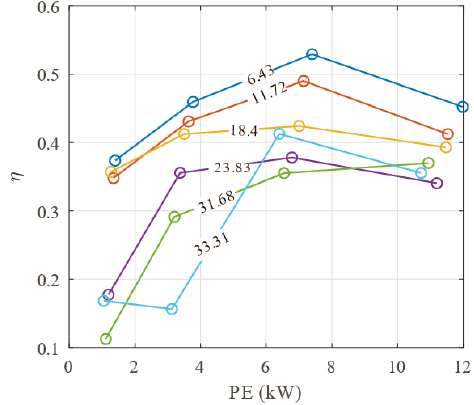
Figure 7. Motor efficiency database for the DP system.